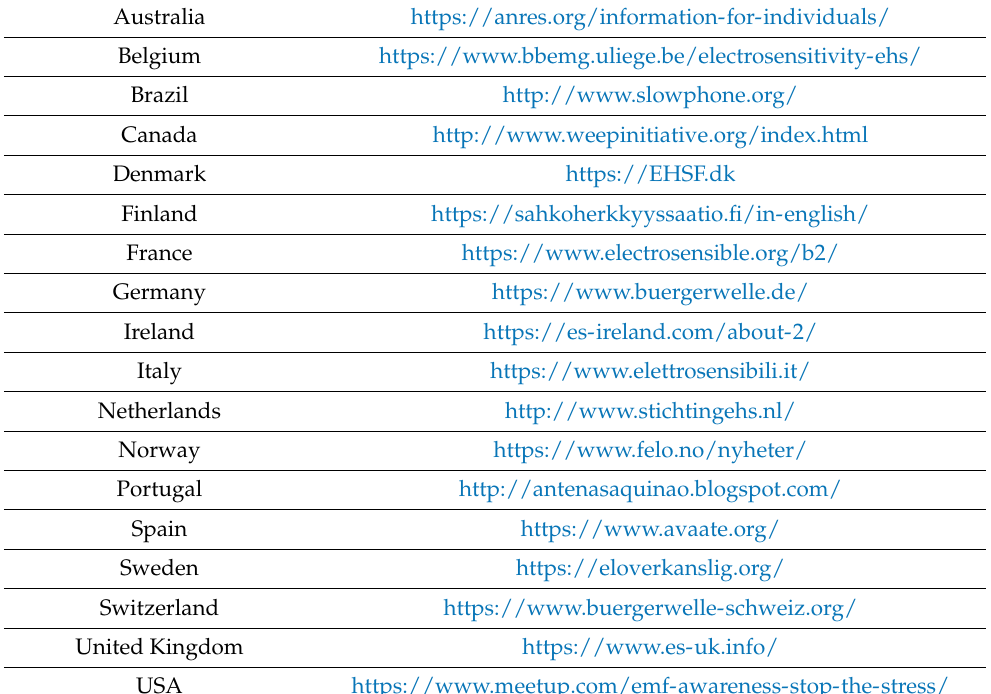
Table 2. Electrosensitive Groups spontaneously formed throughout the world. All sites were accessible on 19 January